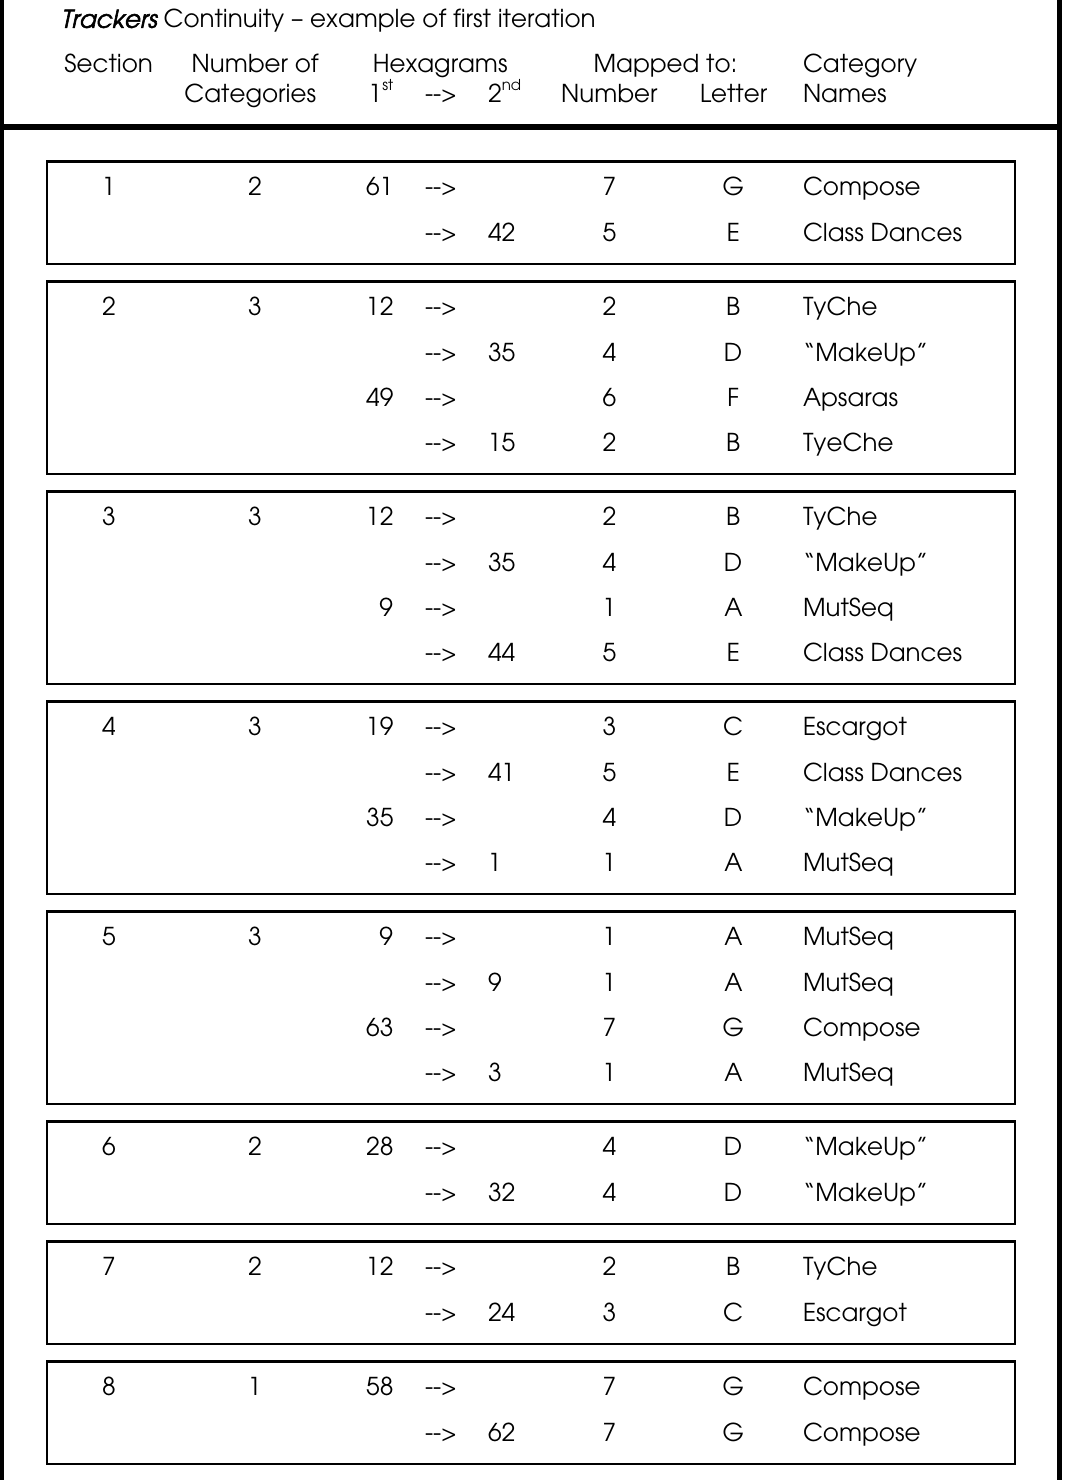
Figure 4.5 Trackers continuity, first